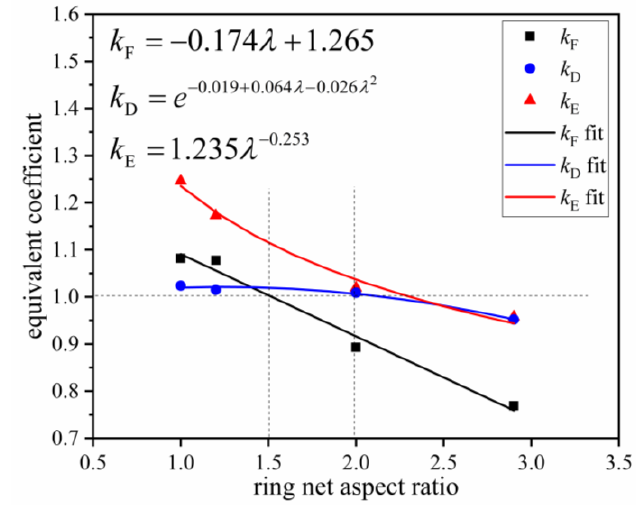
Figure 19. Equivalent coefficients at different ring net aspect ratios.